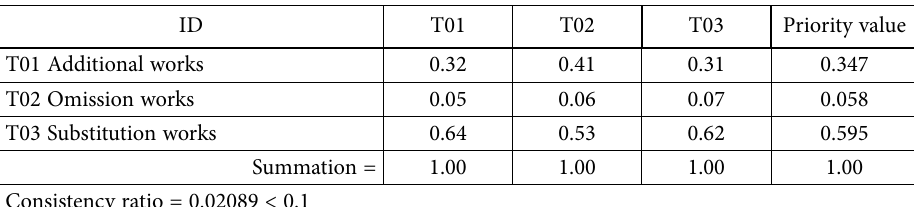
Table 7. Change order types priority values